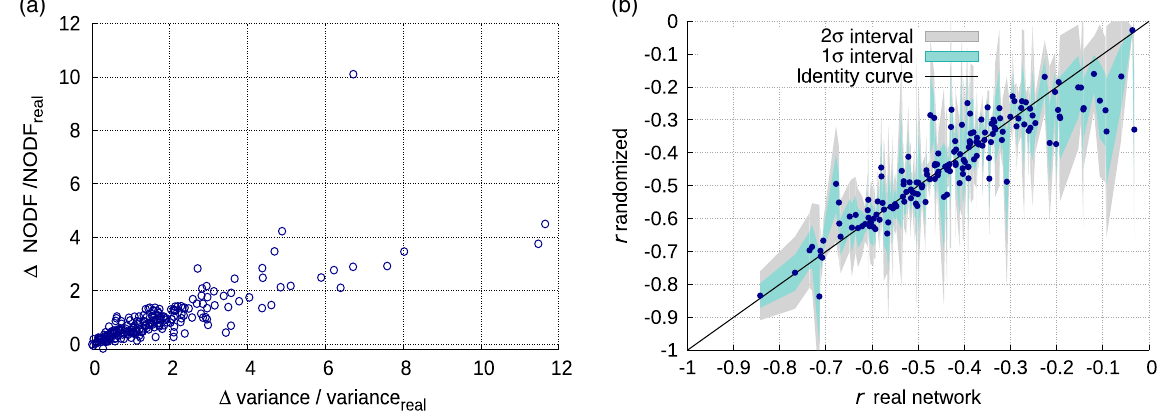
FIG. 8. Determinants of nestedness. (a) Relative change in nestedness and the corresponding change in heterogeneity measured for the set of 167 empirical networks and the average over the respective rewired ones. We use the rewiring algorithm described in Appendix H. Nestedness is measured using the NODF metric, whereas the heterogeneity is measured through the variance of the degree sequence of the unipartite adjacency matrix. We find a correlation index for a linear fit (excluding the top outlier) of R ¼ 0 . 88 . This closely linear relationship discovers a tight bound between nestedness and heterogeneity. (b) A comparison between the real observation of the degree assortativity r (Pearson ’ s coefficient among degrees) and the average estimation in the statistical ensemble for the 167 networks of our study. The fact that r < 0 for all values indicates that both real networks and the average of the randomized ensemble are naturally